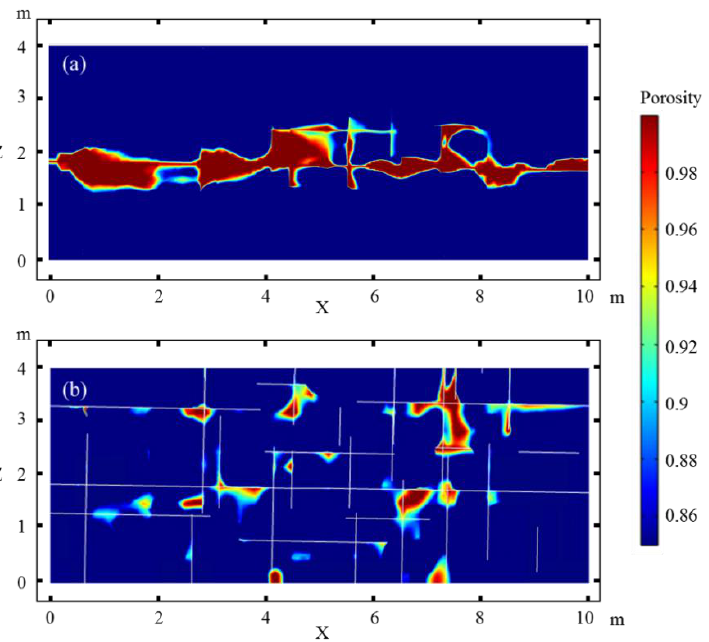
Figure 7. Effects of a complex fracture network with different flow directions. ( a ) Horizontal flow, ( b ) vertical flow.